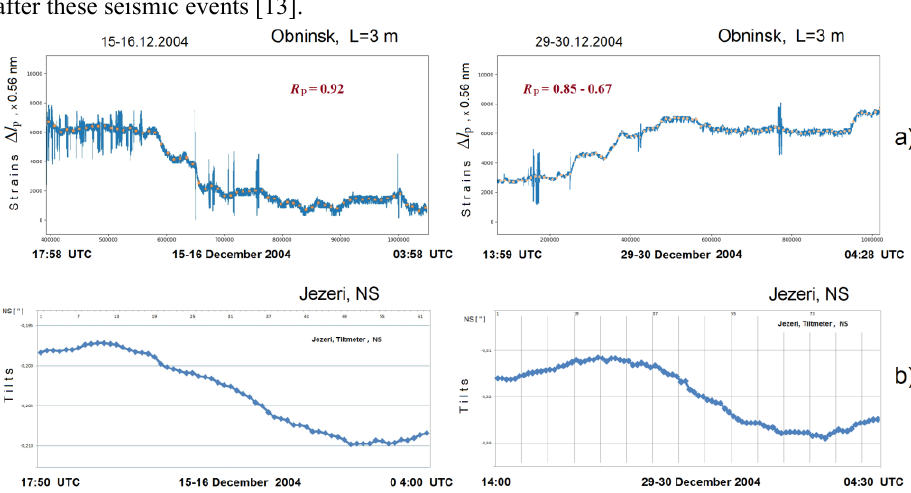
Fig. 3. Pre-seismic and post-seismic correlation of OBN strain-baric (a) and JZR tilts (b) variations in period of Macquarie Mw 8.1 and Sumatra Mw 9.1 earthquakes in December